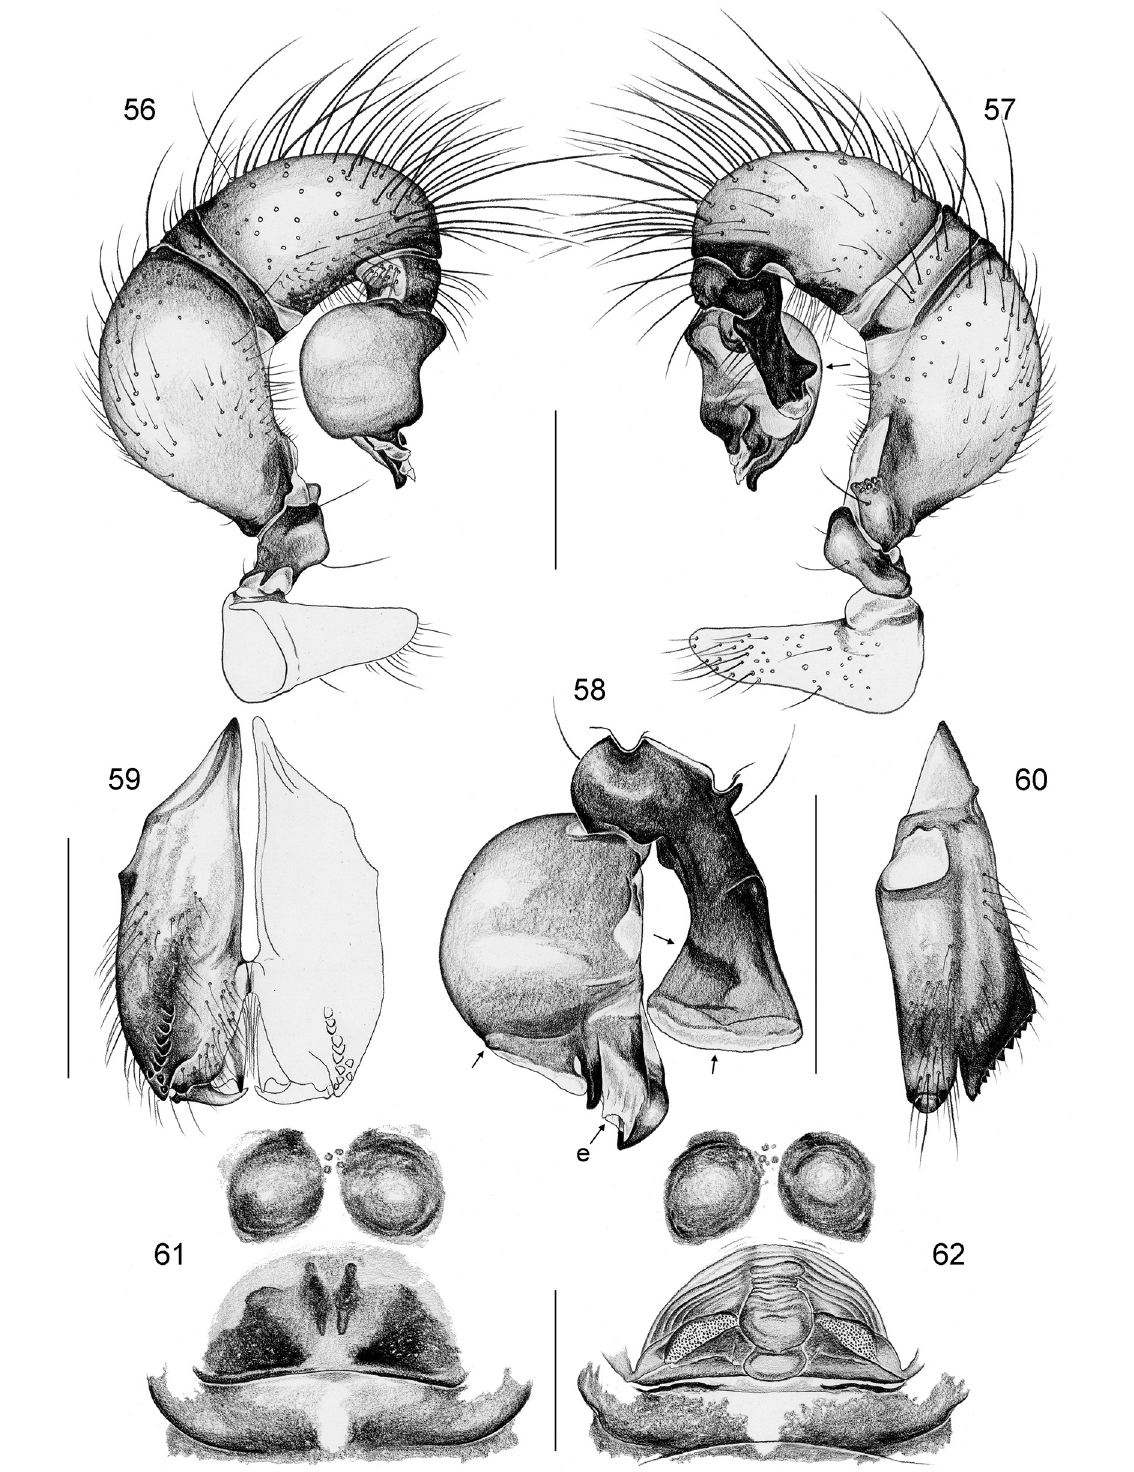
Figs 56-62. Artema bunkpurugu sp. nov. 56-57 . Left ♂ palp, prolateral and retrolateral views. 58 . Left procursus and genital bulb, dorsal view (e: embolus). 59-60 . ♂ chelicerae, frontal and lateral views. 61- 62 . Cleared ♀ genitalia, ventral and dorsal views. Arrows point at distinctive structures (as compared with A. atlanta ). Scale lines: 1